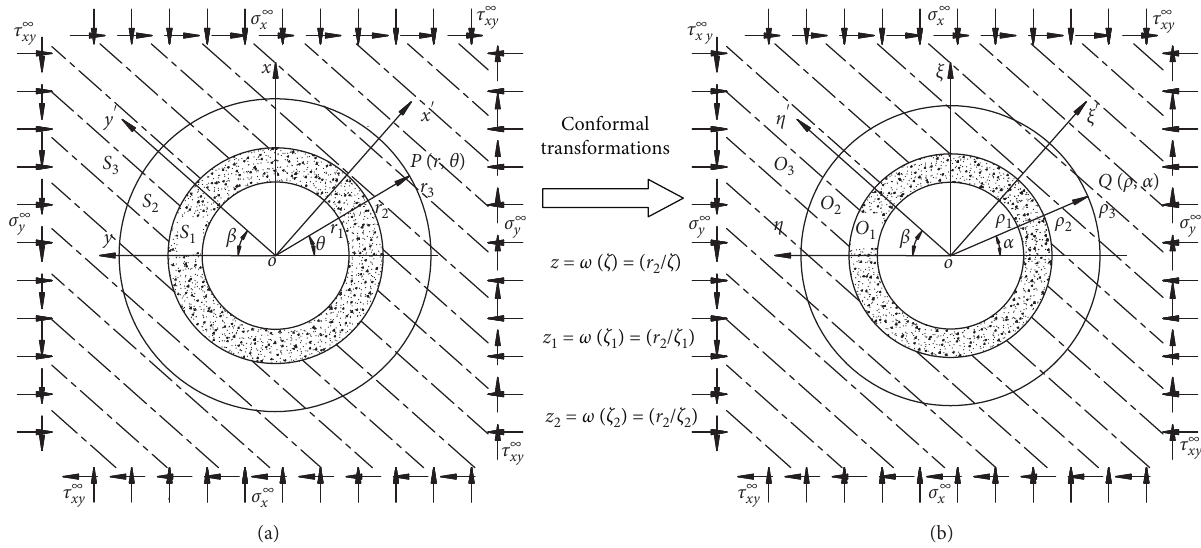
Figure 2: Calculation model of the frost heaving force considering the transversely isotropic characteristics of surrounding rock. (a) Calculation model in the physical plane (z-plane). (b) Calculation model in the image plane ( ζ